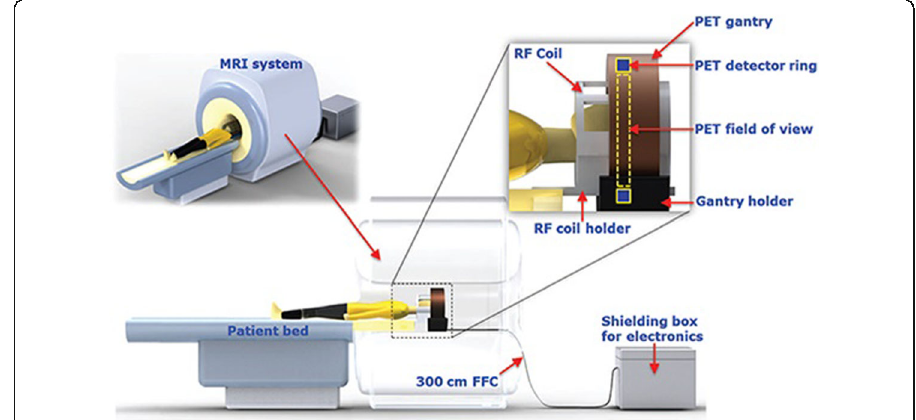
Fig. 5 Illustration of PET/MRI integration showing the placement of the PET gantry, RF coil and shielding box (This research was originally published in K. J. Hong et al., “ A prototype MR insertable brain PET using tileable GAPD arrays, (Hong et al. 2013) ” Med. Phys. , vol. 40,no. 4,